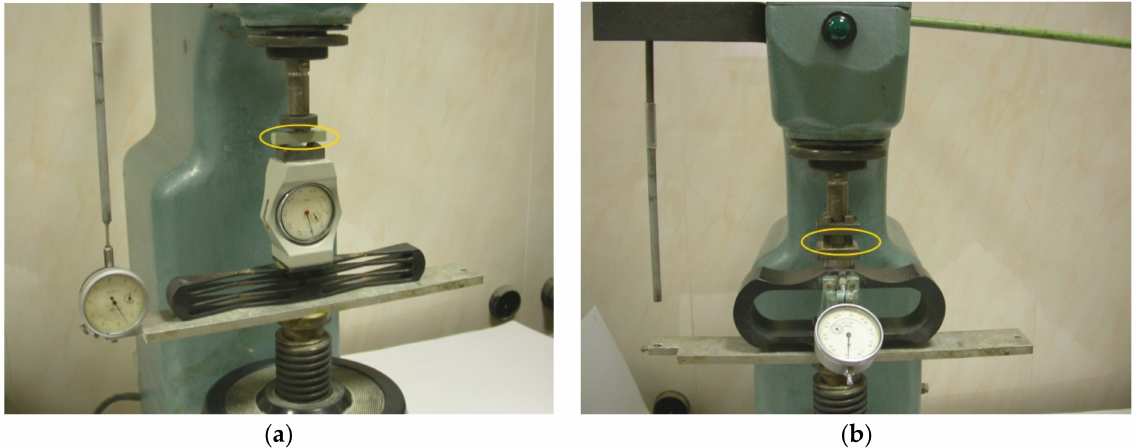
Figure 1. Setup for determining the strength in flexion ( a ) and compression ( b